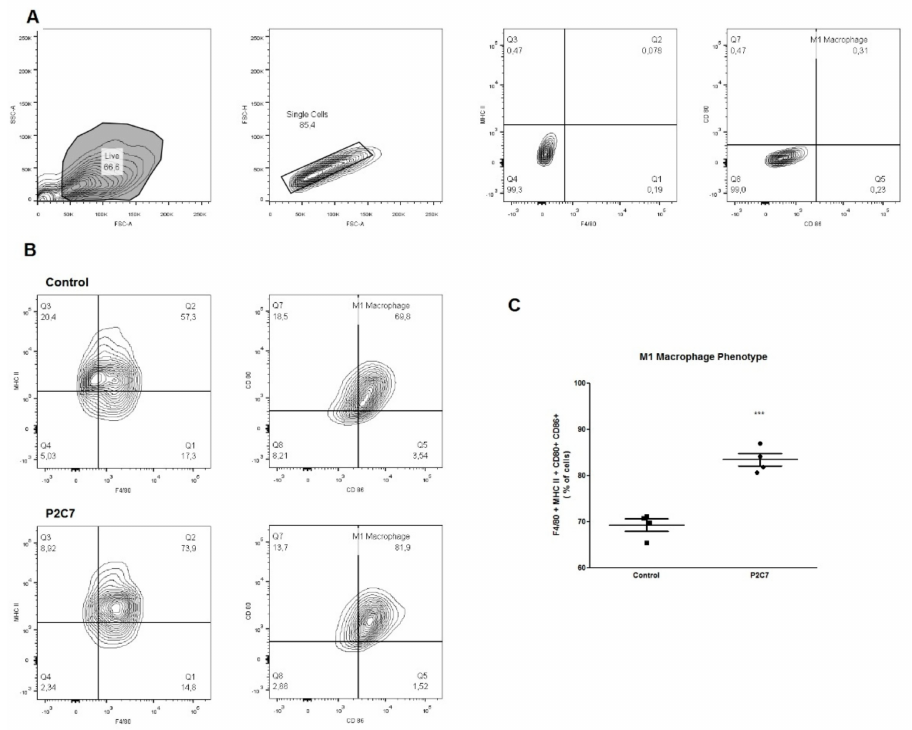
Figure 5. The P2C7 treatment induces M1 phenotype in BMDM. 1 × 10 6 BMDMs were treated with 100 µ g / mL P2C7 or not treated (control) for 48 h. After incubation, the cells were washed and stained with anti-F4 / 80-FITC, anti-MHC II-APC-Cy7, anti-CD80-PE, and and-CD86-APC. After selecting the gates with non-stained cells ( A ), the BMDMs treated with P2C7 promoted an increase of the M1 macrophages population ( B , C ). The statistical analyses were performed with Student’s t -test, *** p < 0.005 ( n =